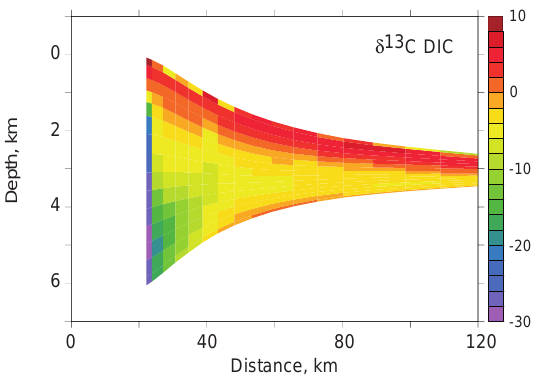
Fig. 15. Carbon isotopic composition, δ 13 C, of dissolved inorganic carbon, for the Base scenario, with various other scenarios in the Supplement file del13dic.pdf. An animation of δ 13 C of methane and DIC (Fig. 14) can be seen at http://geosci.uchicago.edu/ ∼ archer/ spongebob